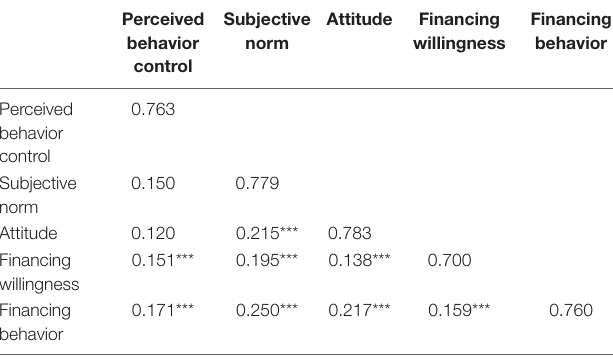
TABLE 5 | Results of discriminant validity